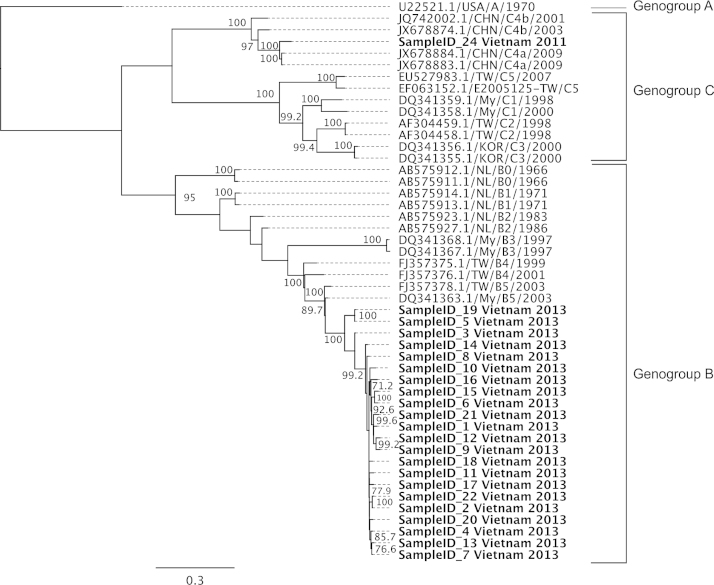
ML phylogeny based on complete genomes (in bold) obtained in this study and those of representatives of EV-A71 downloaded from the GenBank. A similar result was obtained when VP1 sequences were analyzed separately (data not shown). The tree is rooted on a single genogroup A sequence (USA/A/1970) and all horizontal branch lengths are drawn to a scale of nucleotide substitutions per site. Bootstraps >70% are also shown. My: Malaysia, TW: Taiwan, NL: the Netherlands, KOR: Korea, CHN: China.